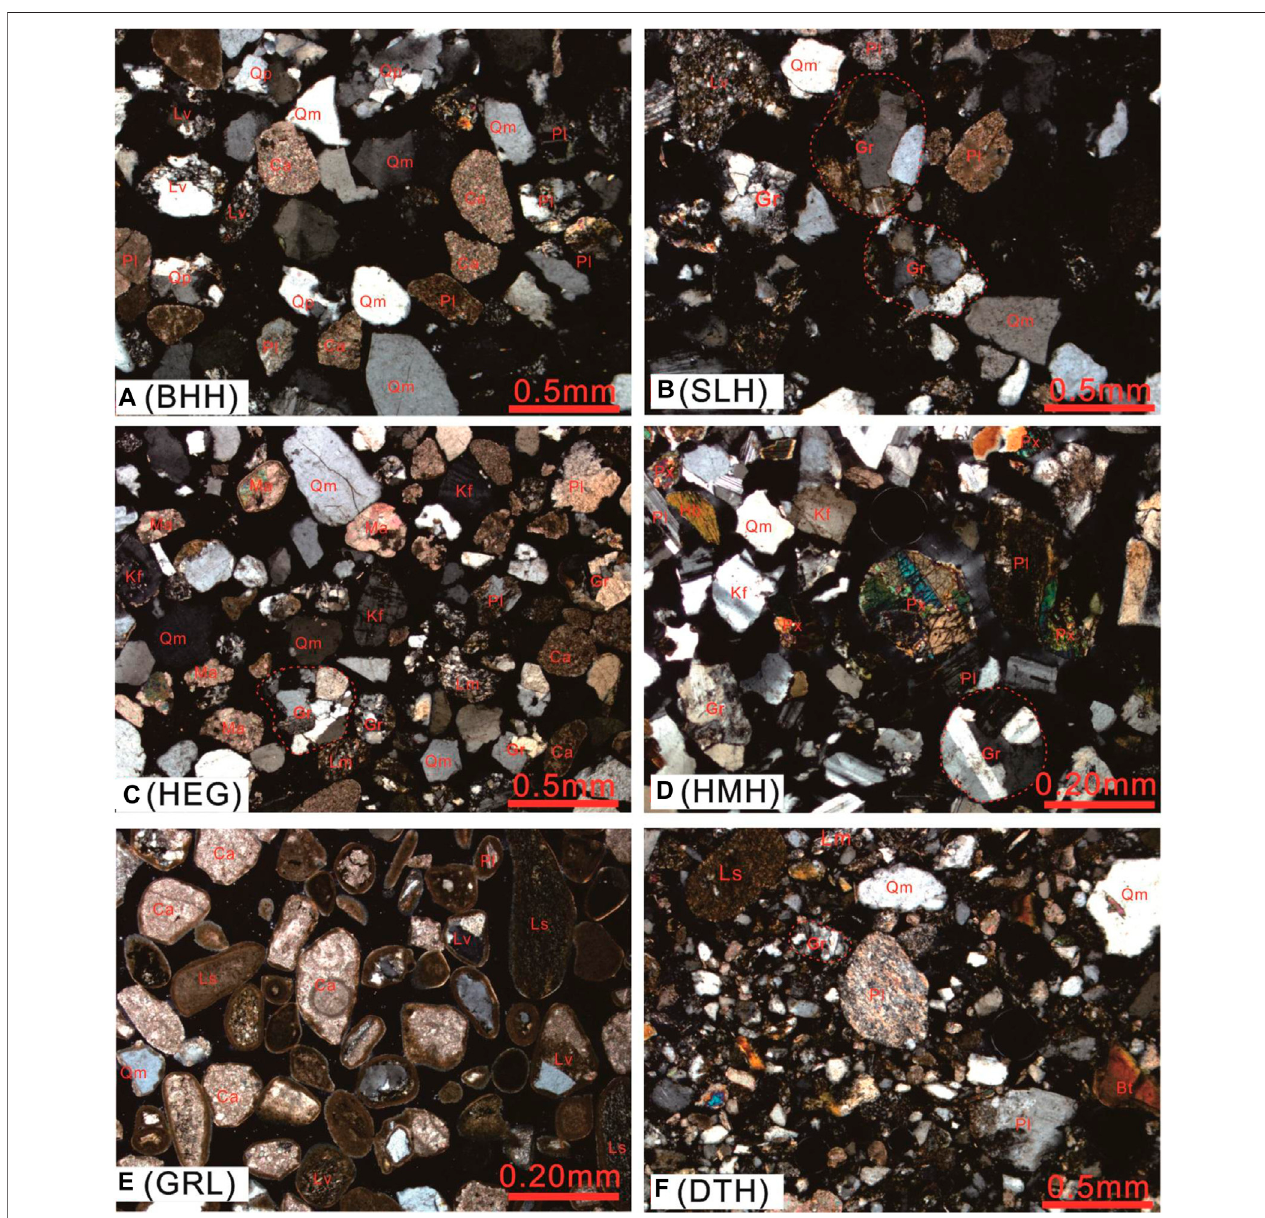
FIGURE 2 | Photomicrographs of the sand sediments from the rivers of Qinghai Lake, cross-polarized light. (A) Sands from Buha River (BHH). (B) Sands from Shaliu River (SLH). (C) Sands from Shaliu River (SLH). (D) Sands from Heima River (HMH). (E) Sands from foreshore near Garila village (GRL). (F) Sands from Daotang River(DTH).Qm:monocrystallinequartz,Qp:polycrystallinequartz,Lv:volcanicfragment,Lm:metamorphicfragment,Ls:sedimentfragment,Gr:granitefragment,Ca: calcite minerals, Pl: plagioclase, Kf: K-feldspar, Ma: marble, Hb: hornblende, Px: pyroxene, Bt: biotite.